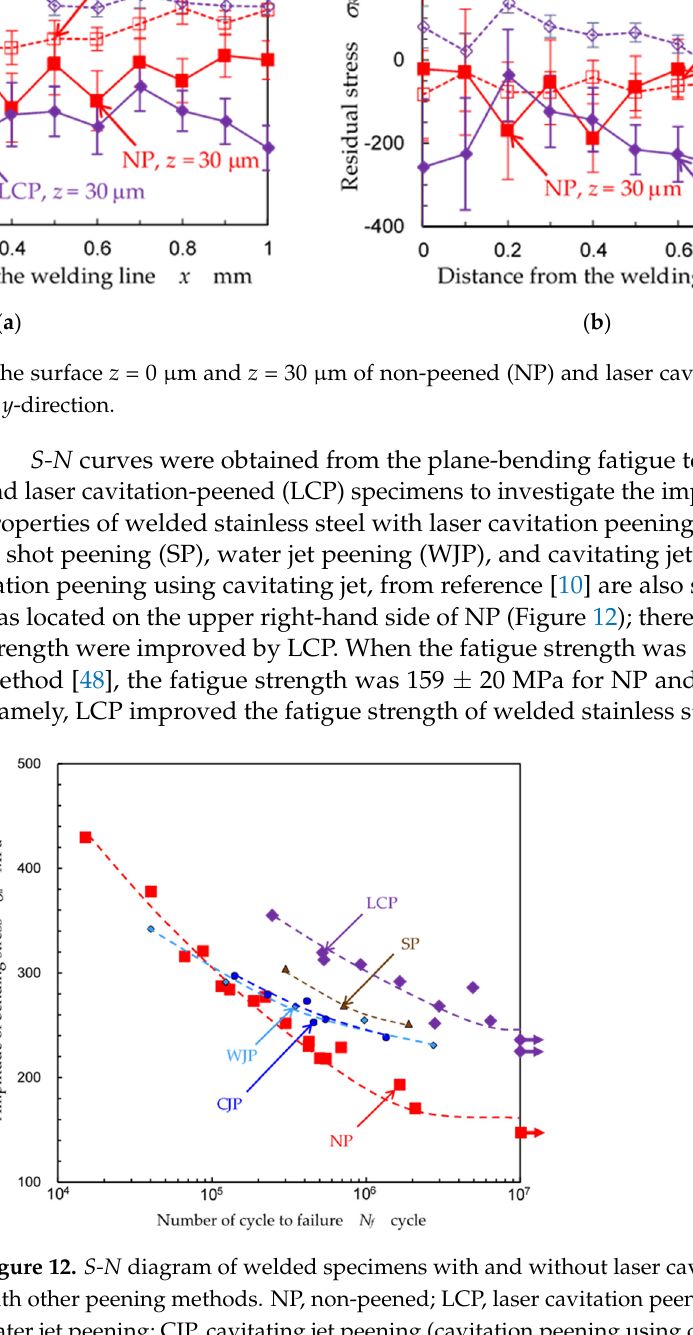
11 of 15 Figure 10. Fractured surface of a welded part. ( a ) Non-peened specimen ( σ a = 229 MPa, N = 688,800); ( b ) specimen treated by laser cavitation peening ( σ a = 319 MPa, N = 516,300). The residual stress σ R as a function of the distance from the welding line x at z = 0 and 30 μ m in the x - and y -directions were calculated to investigate the effect of laser cavitation peening on the residual stress in the HAZ (Figure 11). The measurement location was mid- width, i.e., y = 0 (Figure 9). The tensile residual stress was introduced by laser ablation at